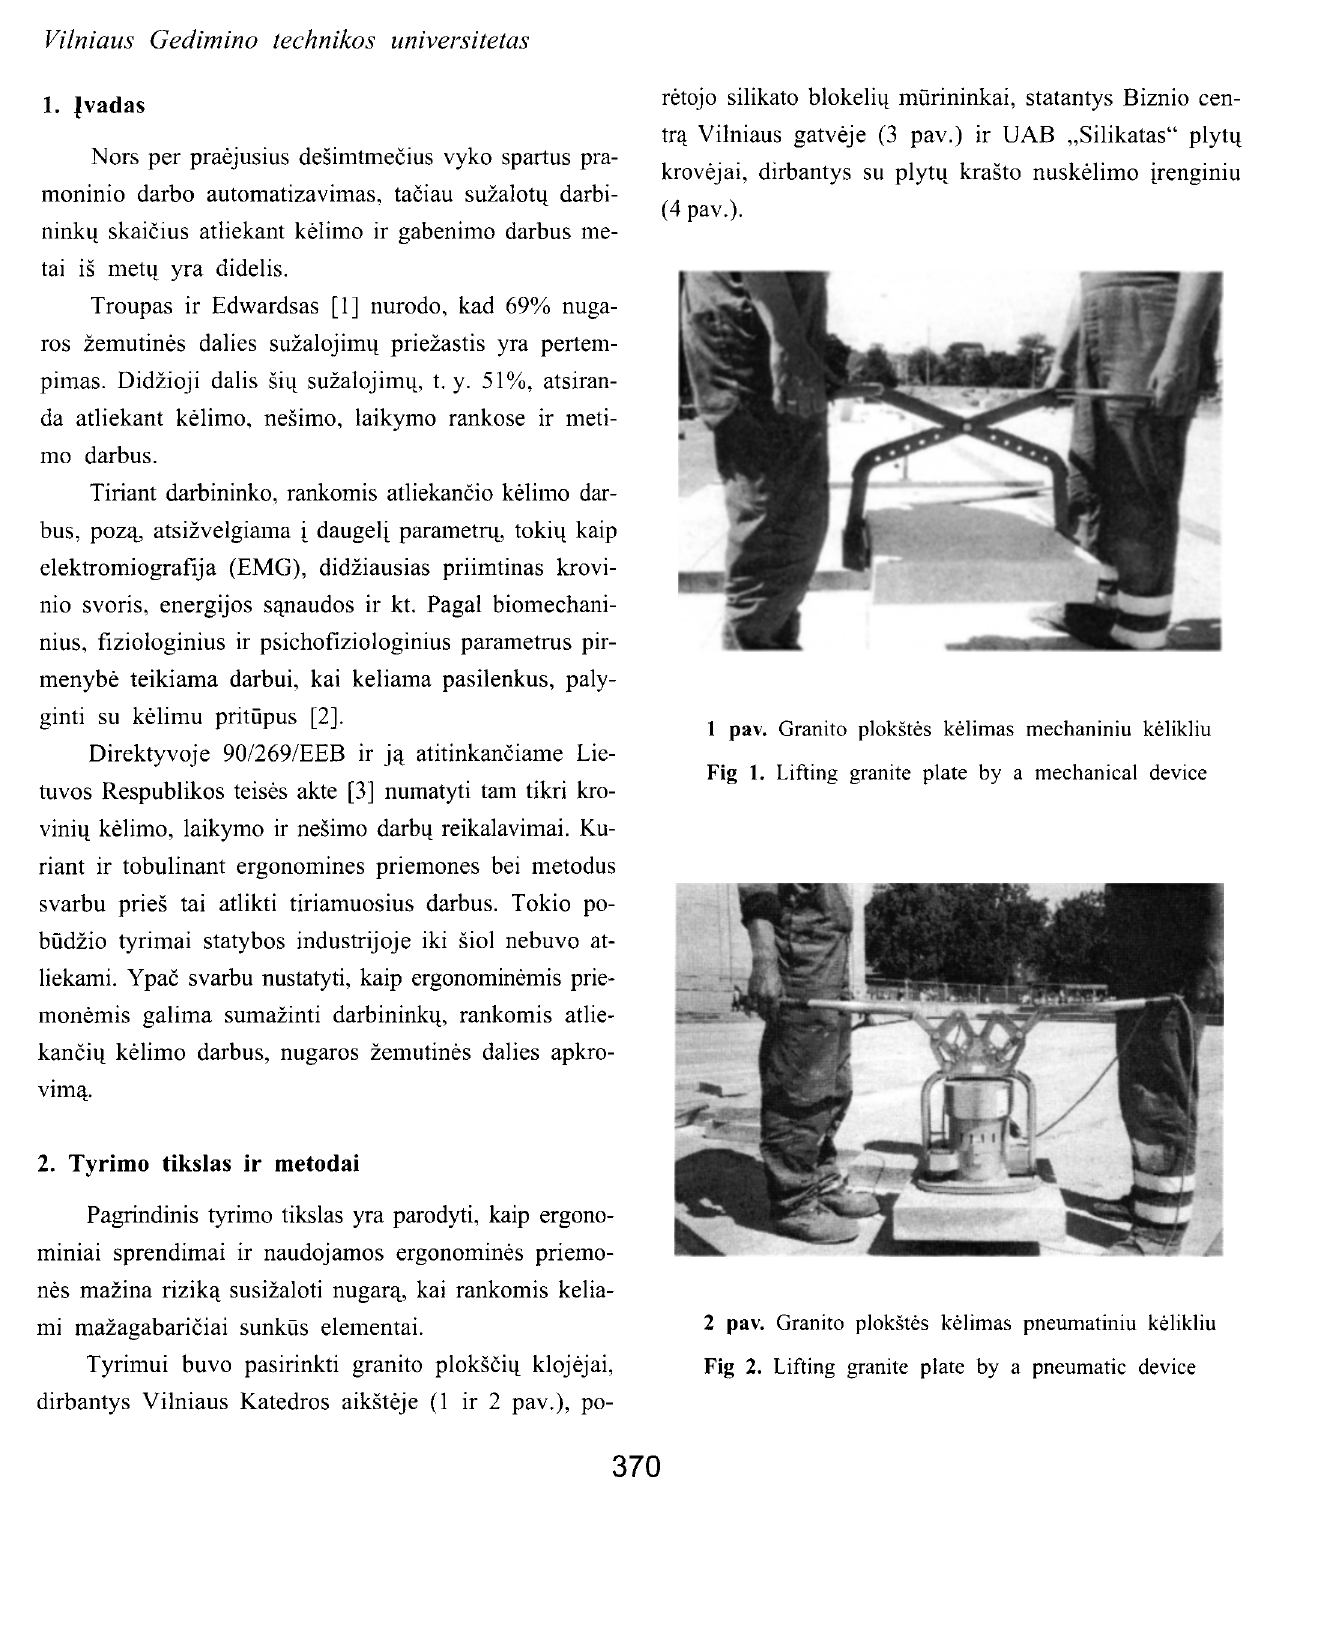
Fig 2. Lifting granite plate by a pneumatic